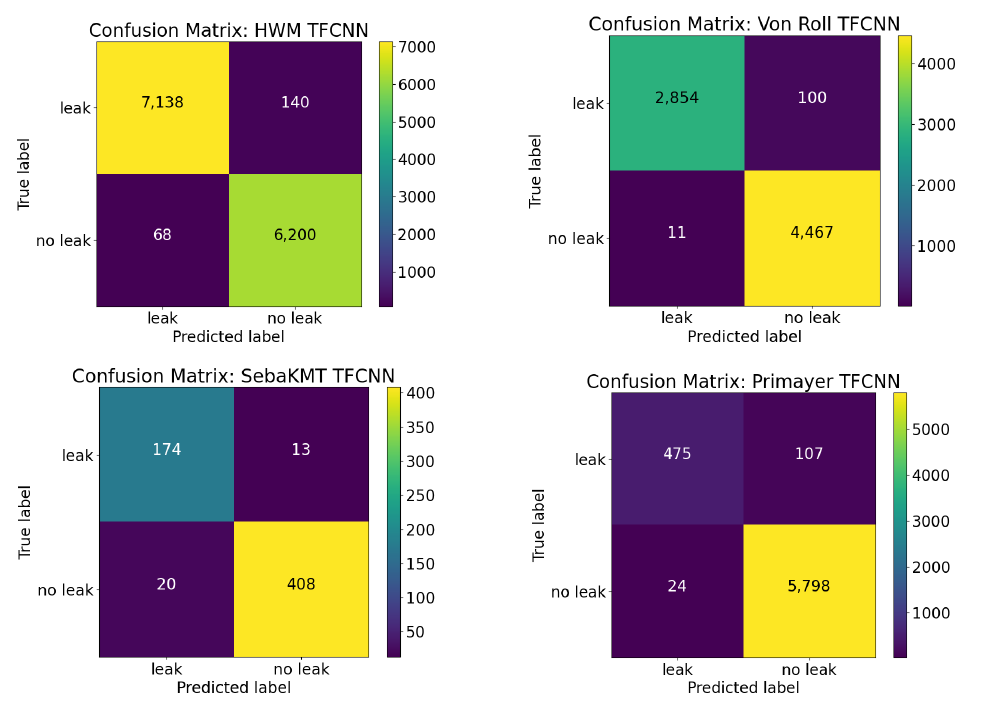
Figure 9. Confusion matrices for TFCNN models. HWM ( top left ), Von Roll ( top right ), Seba KMT ( bottom left ) and Primayer ( bottom right